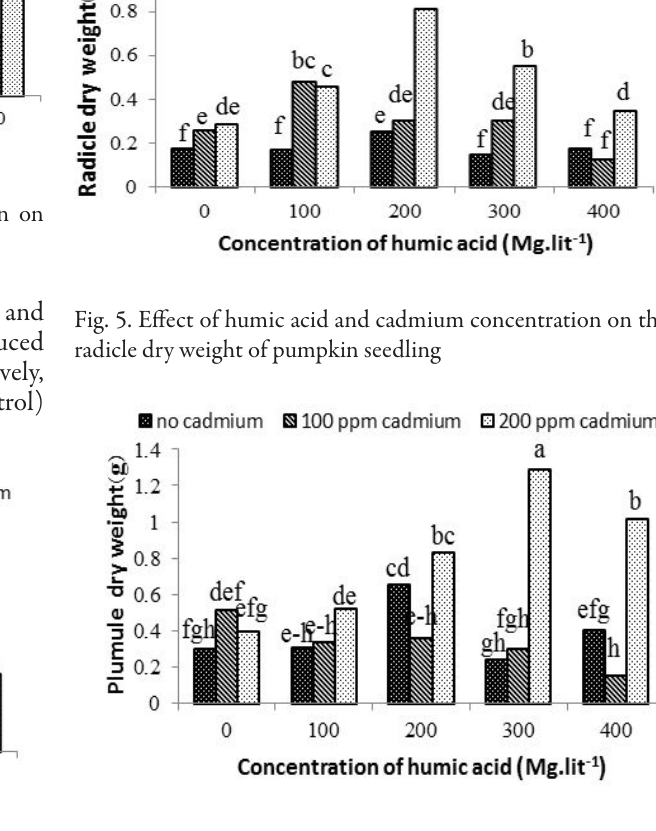
Fig. 6. Effect of humic acid and cadmium concentration on